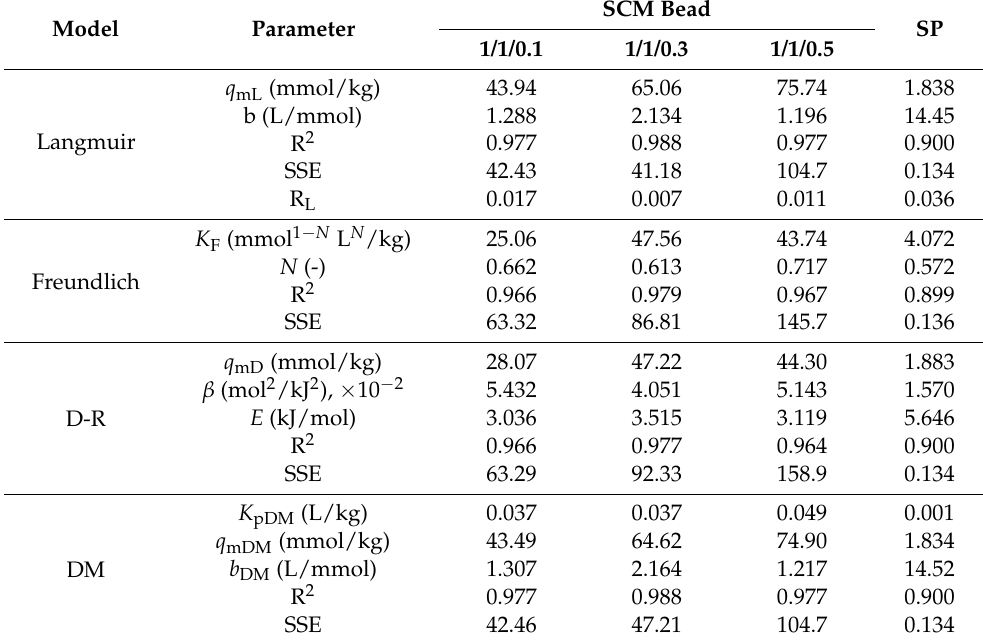
Table 4. Comparison of the isotherm model parameters for As.